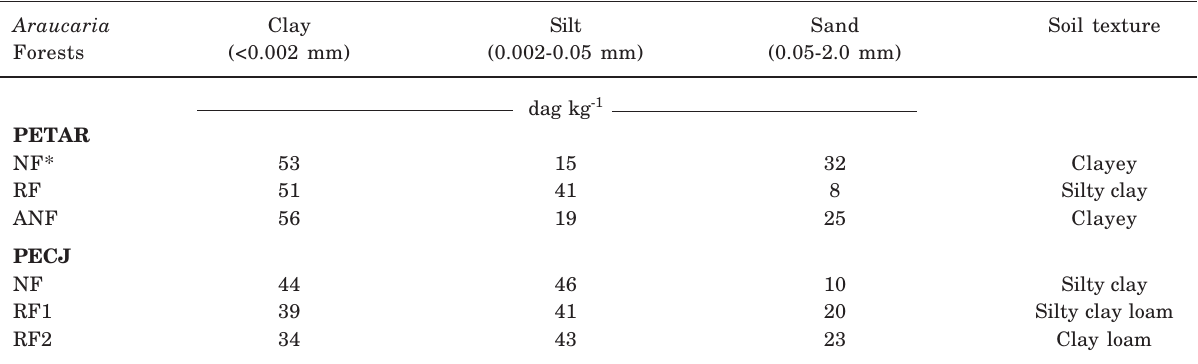
*NF: Natural Forest; RF: Replanted Forest and ANF: Anthropogenically influenced natural